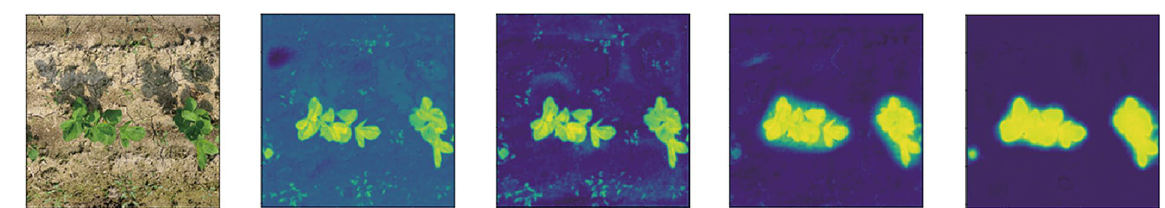
Figure 8. The output of the model at different epochs when training with MGRL. From the left to right, the boundary within the area is captured, but eventually this becomes similar to the manual